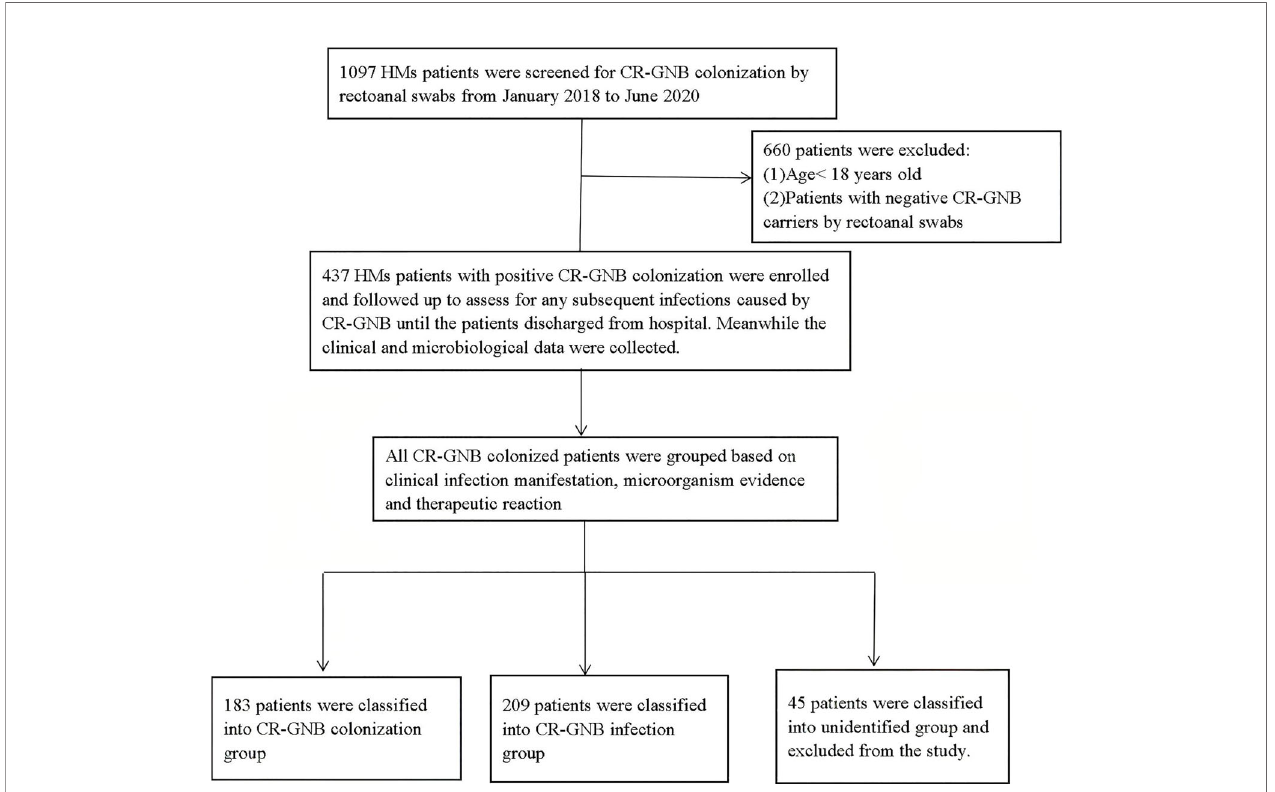
FIGURE 1 | Screening algorithm of the patients with CR-GNB colonization. In all, 437 hospitalized patients had rectoanal swabs positive for CR-GNB, and a total of 392 eligible, unduplicated cases were recruited into this